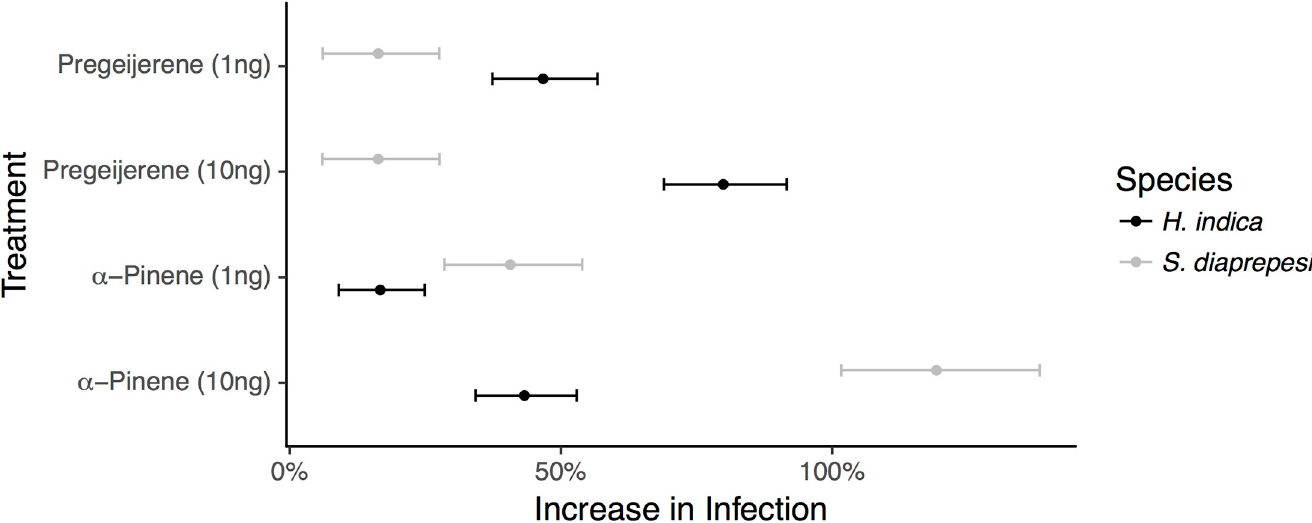
Fig 2. Infection increases in presence of plant volatiles. Increase in numbers of infective juveniles recovered from G. mellonella larvae paired with treatment volatiles. Increase is calculated relative to numbers of infective juveniles recovered from G. mellonella larvae not paired with treatment volatiles. Points and error bars denote means and 95% confidence intervals